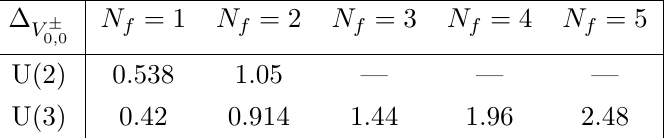
Table 11 . The IR R -charge of the monopole operator V ± the monopole superpotential [48]. Again the values for U(2) with N is irrelevant.